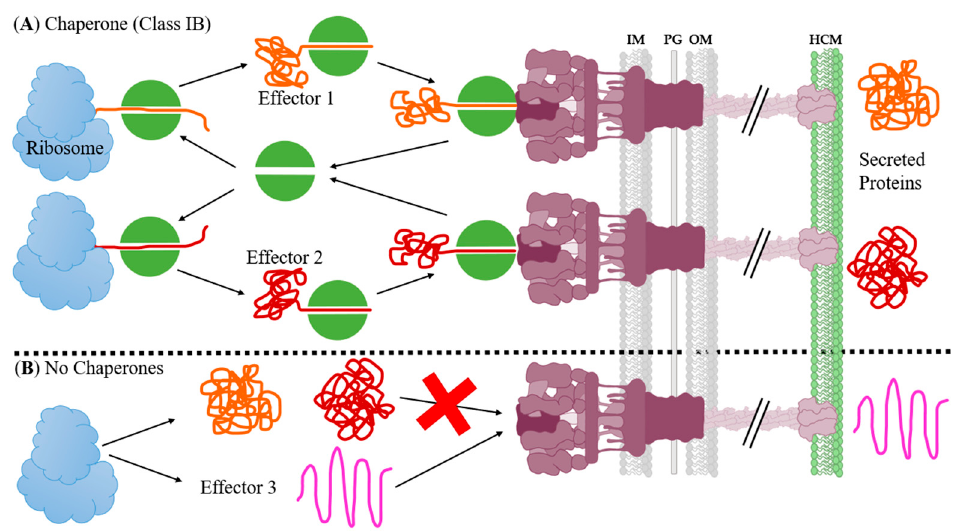
Figure 22. T3SS chaperone protein function. ( A ) Class IB chaperone protein (green) assisting effectors (orange and red) in secretion. ( B ) Without the chaperone, the substrate effectors cannot be secreted. There are some effectors (Effector 3, pink) that do not require chaperones and will be secreted. Modified from [58]. Abbreviations: OM, outer membrane; PG, peptidoglycan; IM, inner membrane; HCM, host cell membrane.